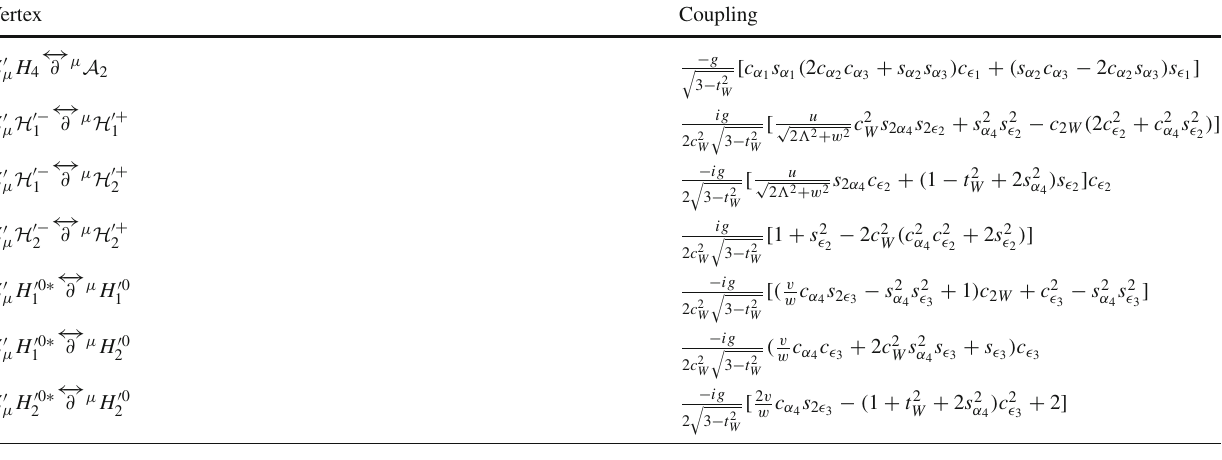
Table 4 The interactions of a charged gauge boson with two scalars